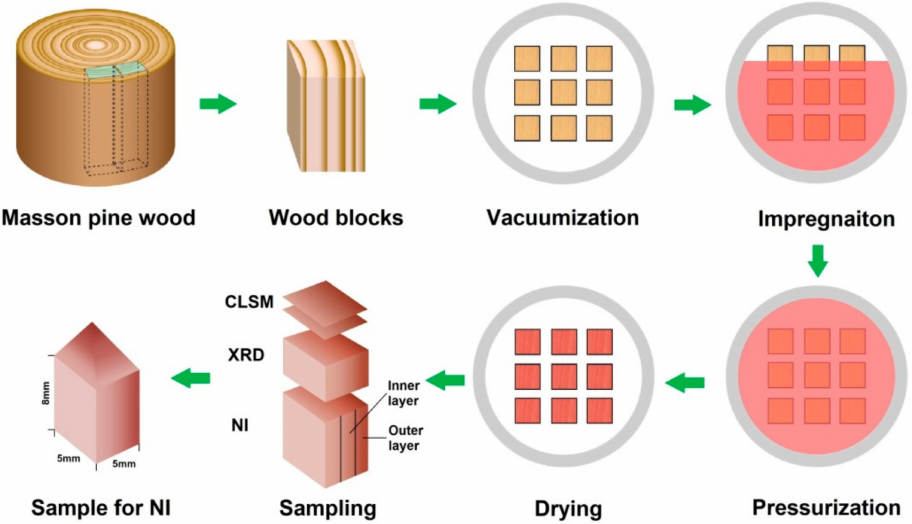
Figure 1. Schematic diagram of wood impregnation and sample